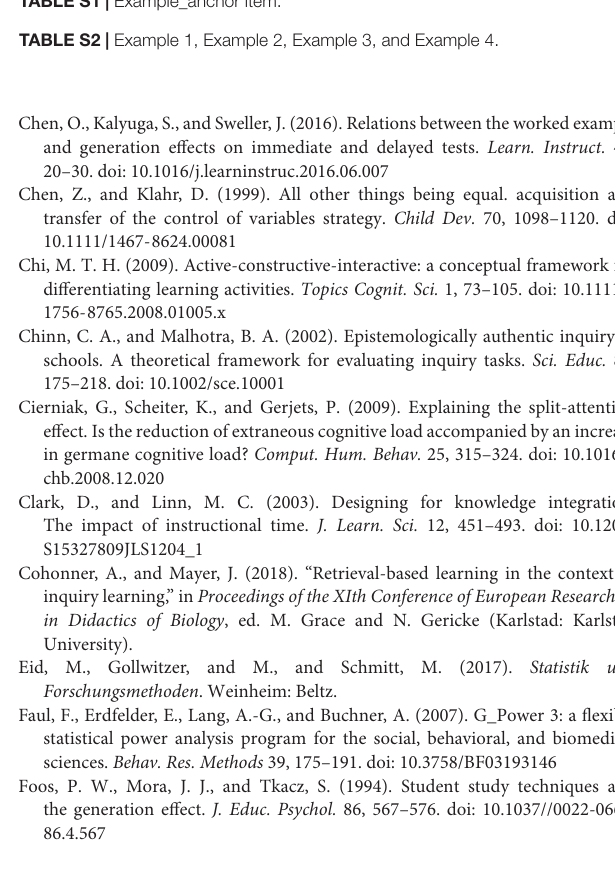
FIGURE S1 | Questionnaire cognitive abilities. FIGURE S2 | Questionnaire_need for cognition. FIGURE S3 | Questionnaire_cognitive load. FIGURE S4 | Pretest. FIGURE S5 | Posttest_1. FIGURE S6 | Posttest_2. FIGURE S7 | Posttest_3. FIGURE S8 | Coding_scheme. FIGURE S9 | Research workbook_GF. FIGURE S10 | Research workbook_R. FIGURE S11 | Supervisor workbook for instructions_GF. FIGURE S12 | Supervisor workbook for instructions_R. TABLE S1 | Example_anchor item. TABLE S2 | Example 1, Example 2, Example 3, and Example